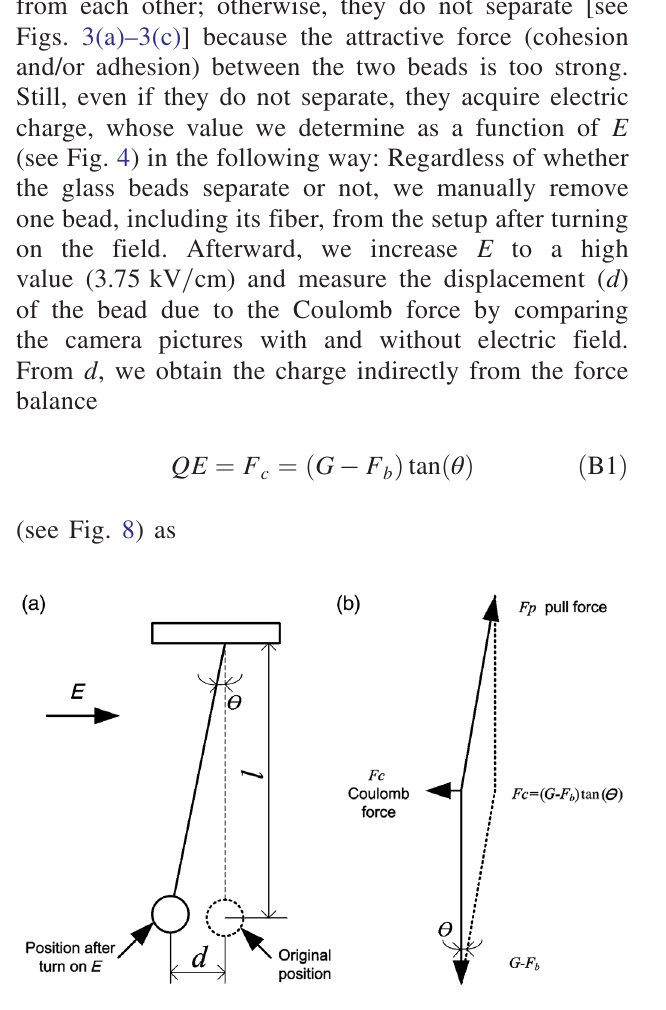
FIG. 8. Sketch of glass-bead displacement due to electric field.